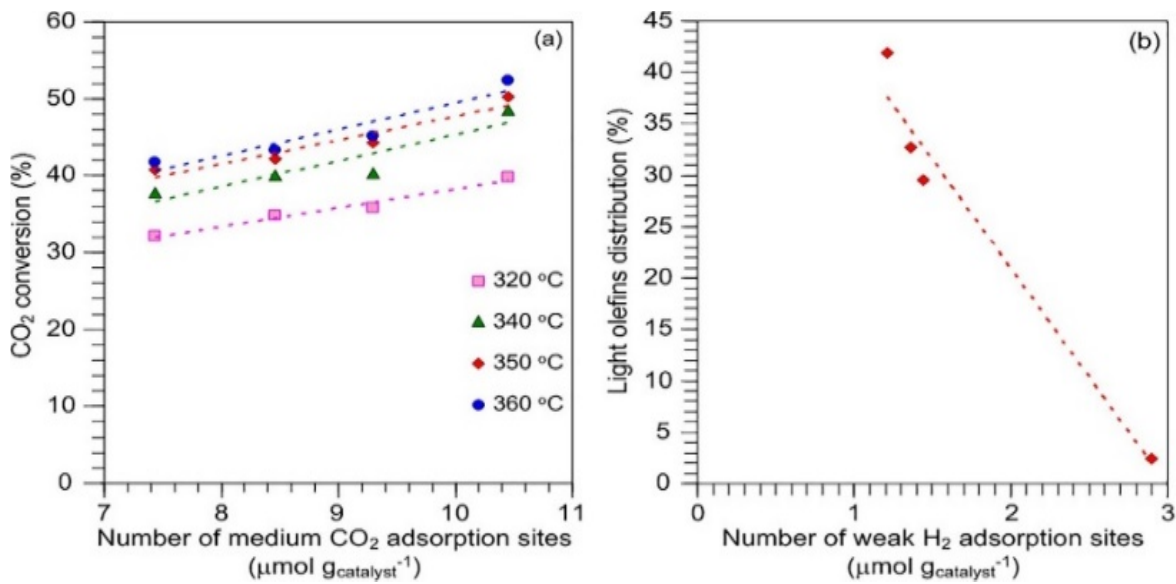
Figure 17. Mechanism of CO 2 activation on the surface of the 13%ZnO–ZrO 2 component of the 13%ZnO–ZrO 2 /Mn–SAPO-34 catalyst. Reproduced from [129] with copyright license from Elsevier (2021).